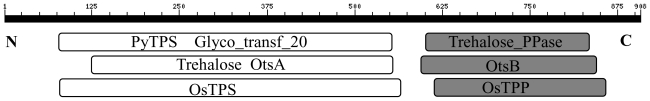
Block diagram of the TPS proteins from P. yezoensis, rice (O. sativa) and bacteria (E. coli). The N-terminal TPS domain is marked as the light-colored boxes (left side), and the C-terminal TPP domain is marked as the dark-colored boxes (right). From top to bottom: the corresponding domains of the TPS proteins from P. yezoensis, E. coli and O. sativa.